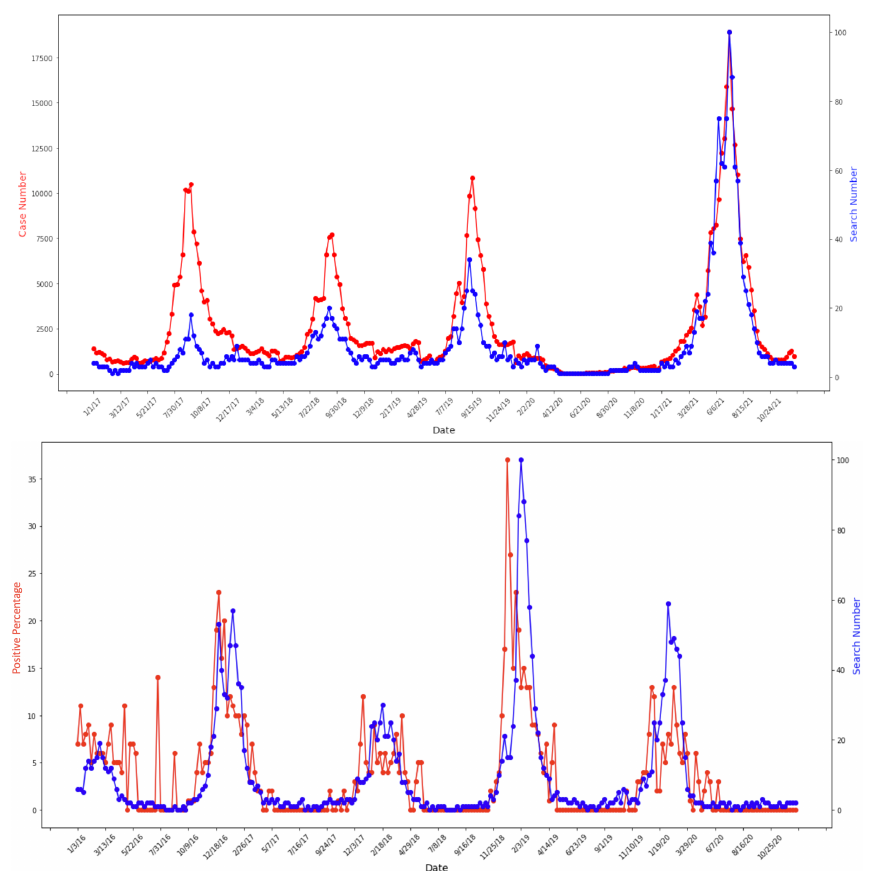
Figure 1. Correlation between Google Trends and case data at country level: Japan 2017–2021 ( top ) Pearson correlation coefficient = 0.87, p -value < 0.0001. Germany 2016–2020 ( bottom ) Pearson correlation coefficient = 0.65, p -value < 0.0001. Google Trends and case data are marked in blue and red accordingly. Y-axis for both Google Trends and case data ranges from the minimum to the maximum values of each function over